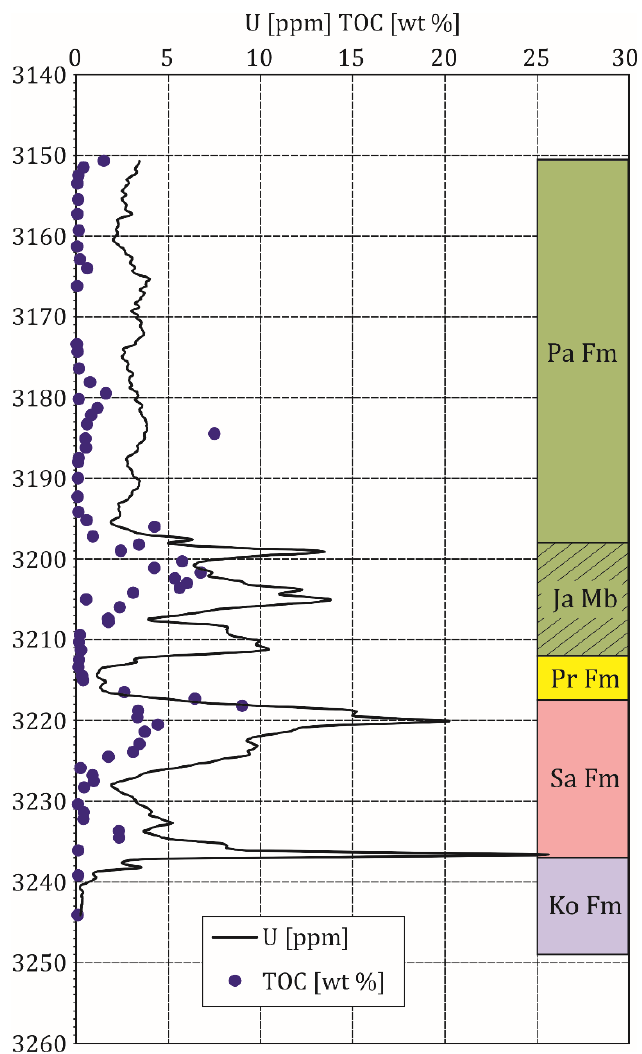
Figure 4. Uranium content (ppm) and TOC content (wt%) vs. depth; Well-1, selected depth section.